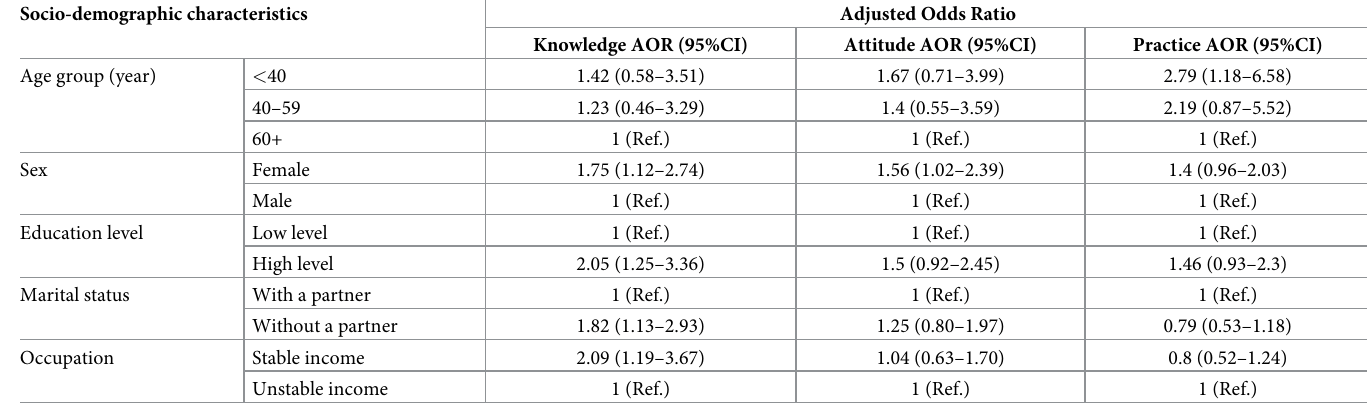
Table 5. Multivariate analysis of factors associated with knowledge, attitudes, and practices related to COVID-19. Socio-demographic